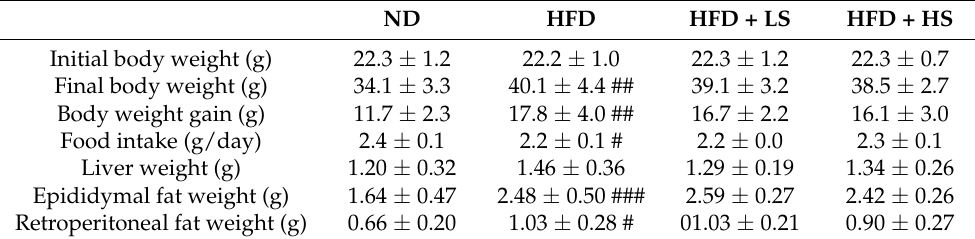
Table 1. Mouse body weight, food intake, and organ weight.